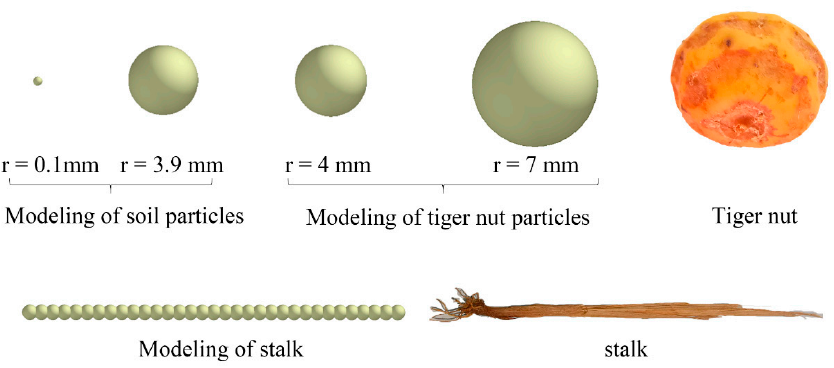
Figure 13. Simulation models of the soil particles, tiger-nut tubers, and stalk [29].